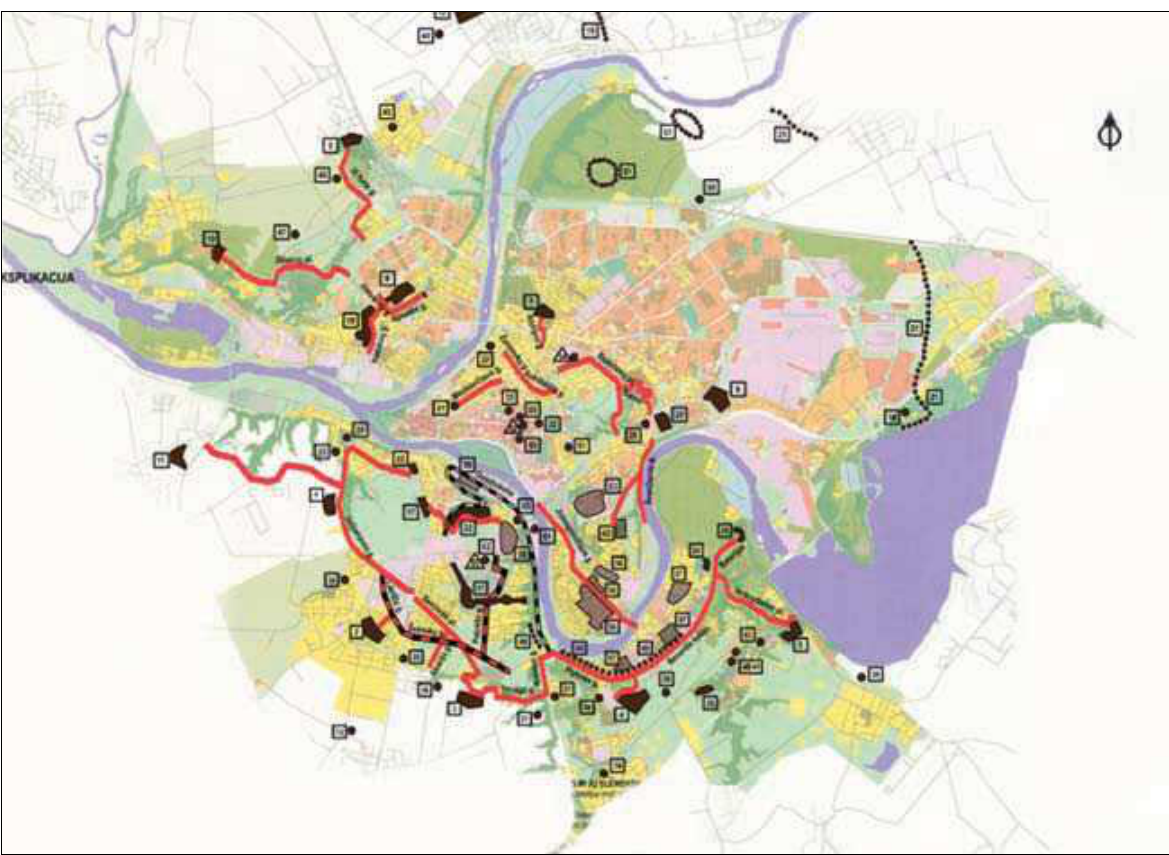
Fig. 1. remaining objects of kaunas